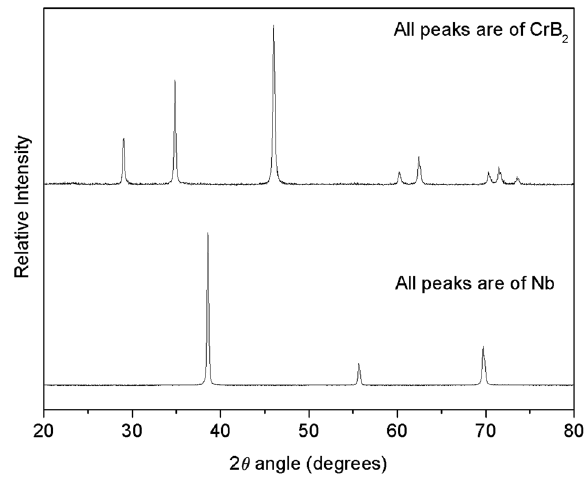
Figure 1 : XRD pattern of starting CrB 2 and Nb powder.